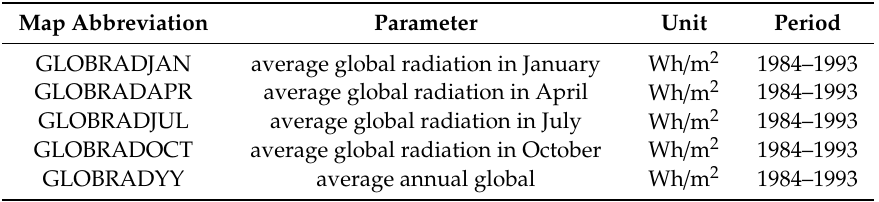
Table 5. Resulting maps of solar radiation.